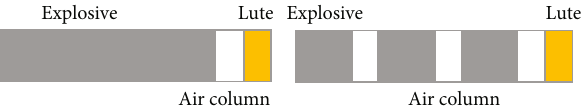
Figure 11: Axial decoupling charge method.